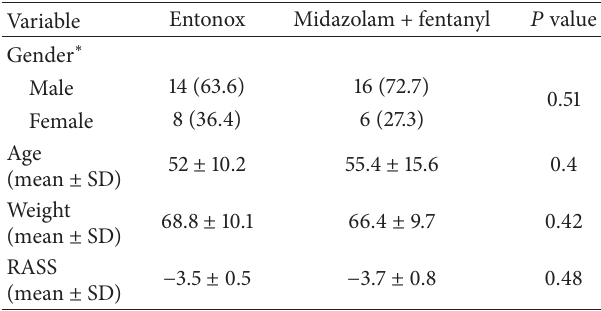
Table 1: The comparison of Entonox group with midazolam and fentanyl group in terms of age, weight, and sedation